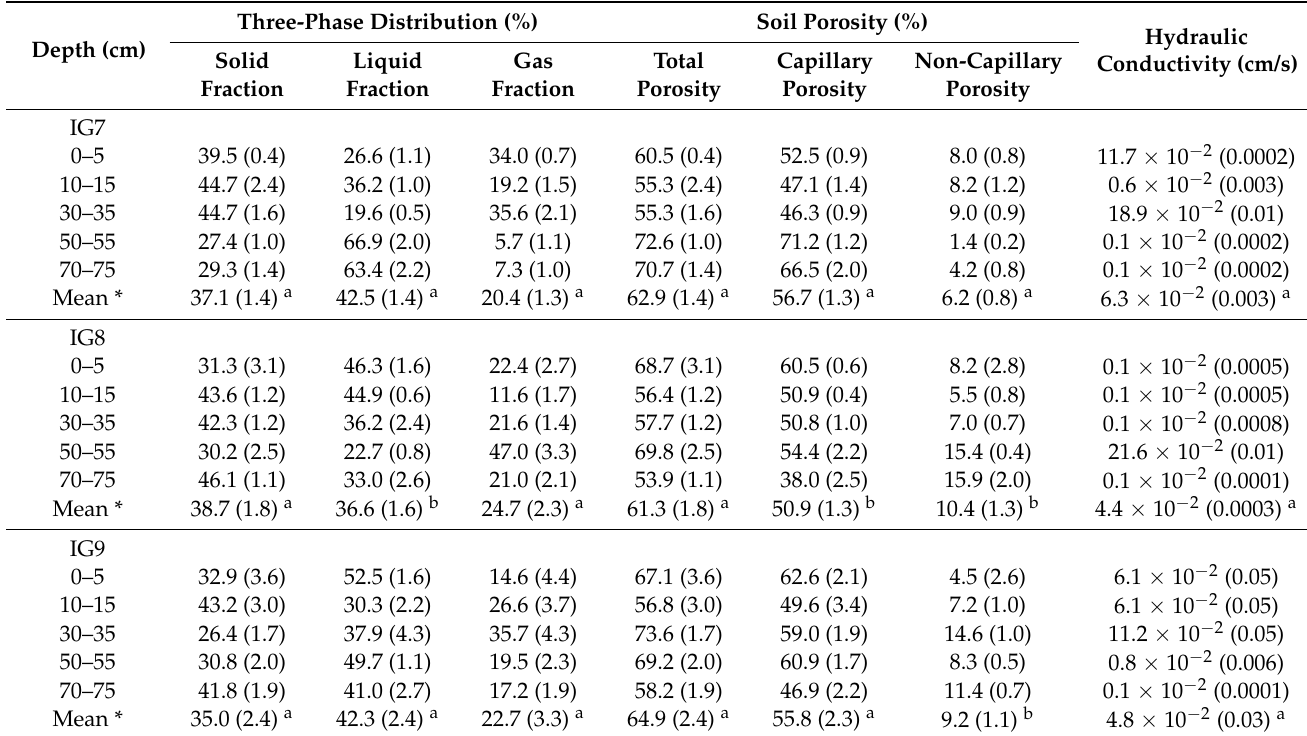
Table 2. Three-phase distribution, soil porosity, and hydraulic conductivity of different sites in 2019 (means and standard error).